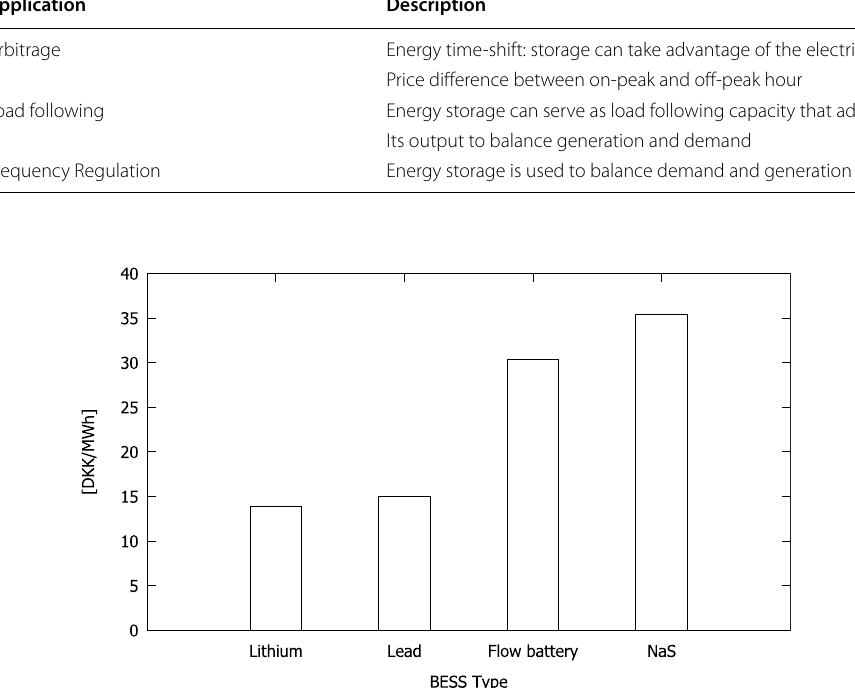
Fig. 5 LCOS results of the four investigated